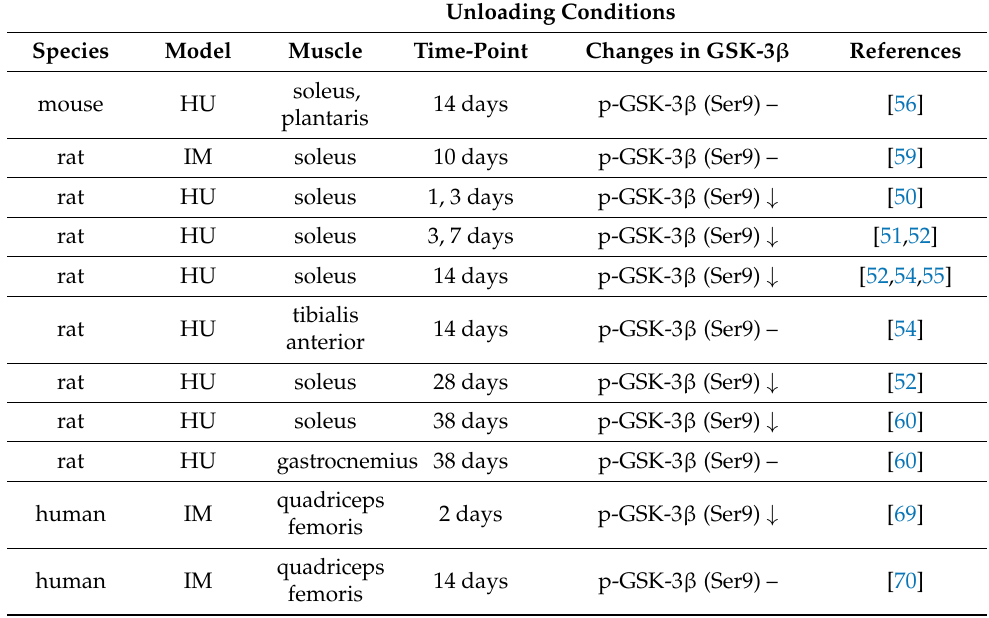
Table 1. The effects of unloading and reloading on GSK-3 β (Ser9) phosphorylation in skeletal